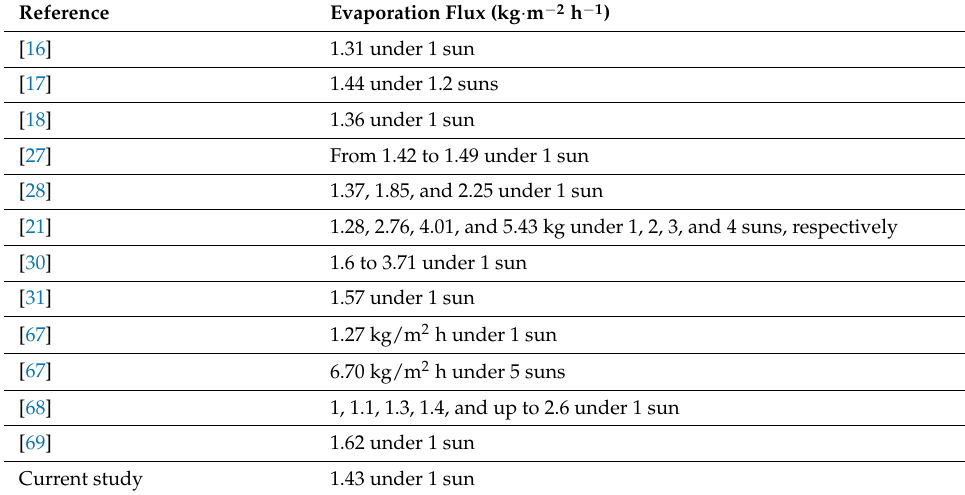
Table 1. Comparison of various evaporation fluxes from various interfacial evaporation studies carried out under different solar